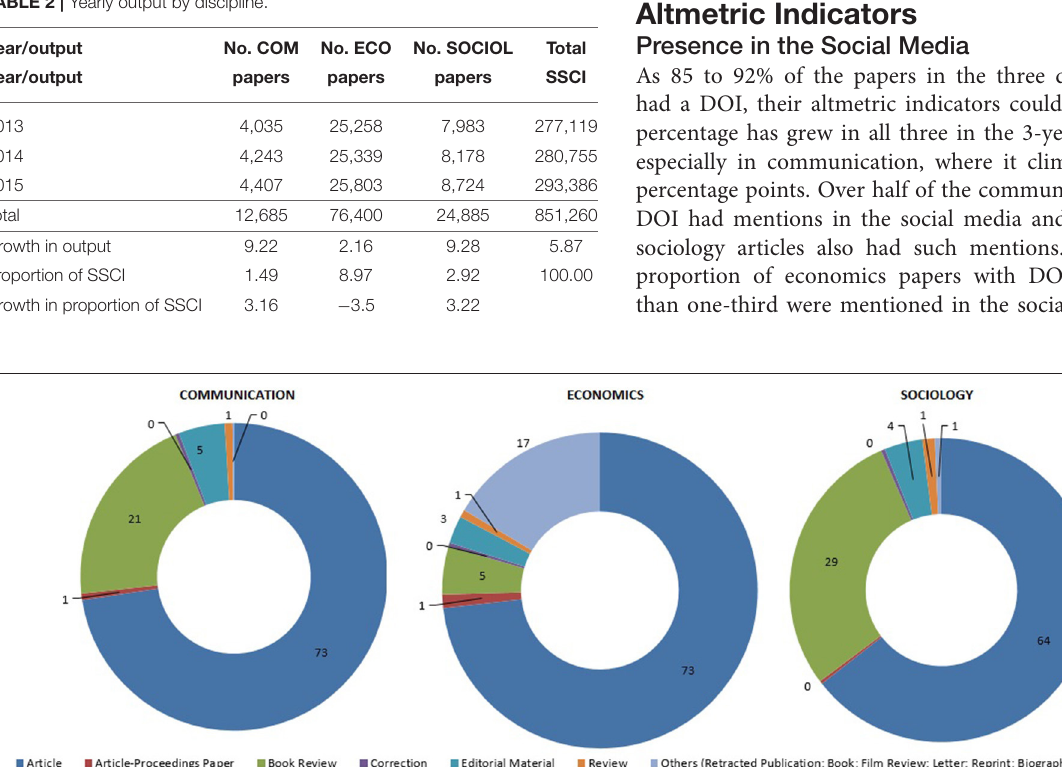
FIGURE 1 | Publications by document type and